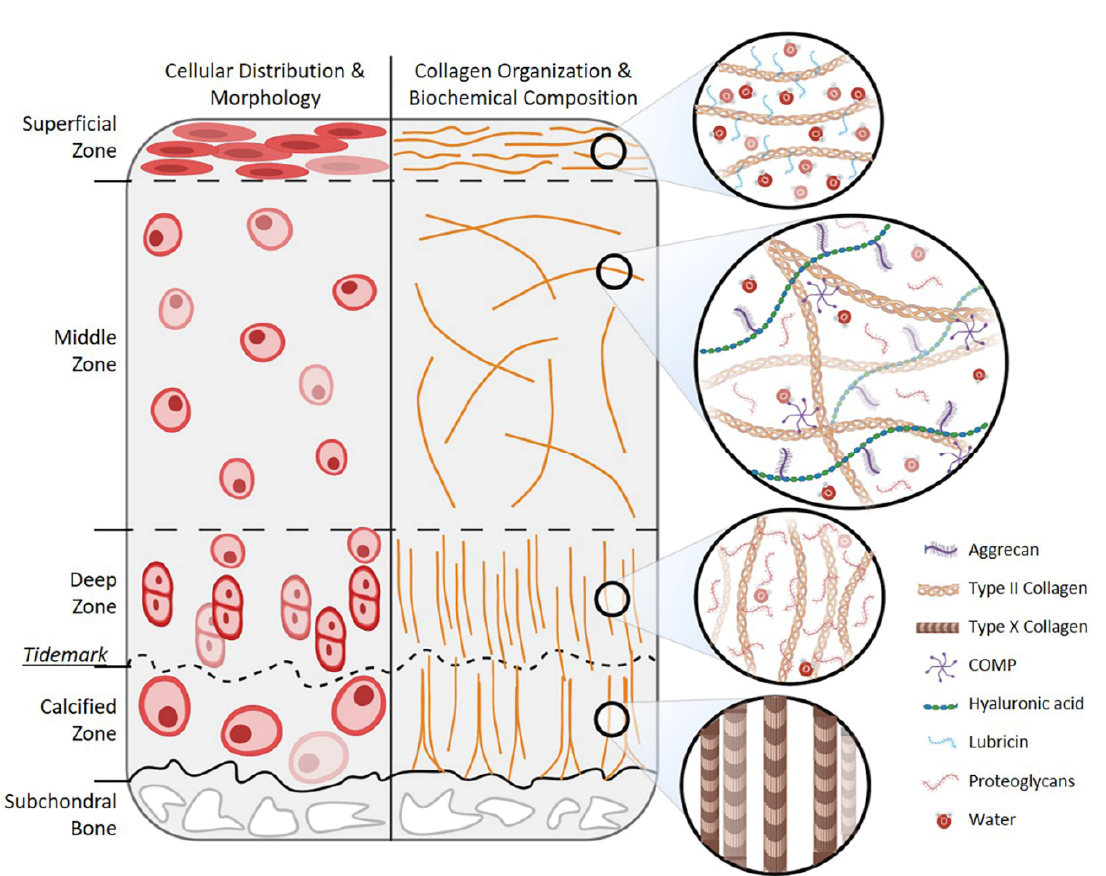
Figure 1. Hyaline cartilage structure and biochemical composition. Schematic representation of hyaline cartilage zonal structure and variable cellular distribution, morphology, collagen organization, and biochemical composition. Created with BioRender.com (accessed on 1 March